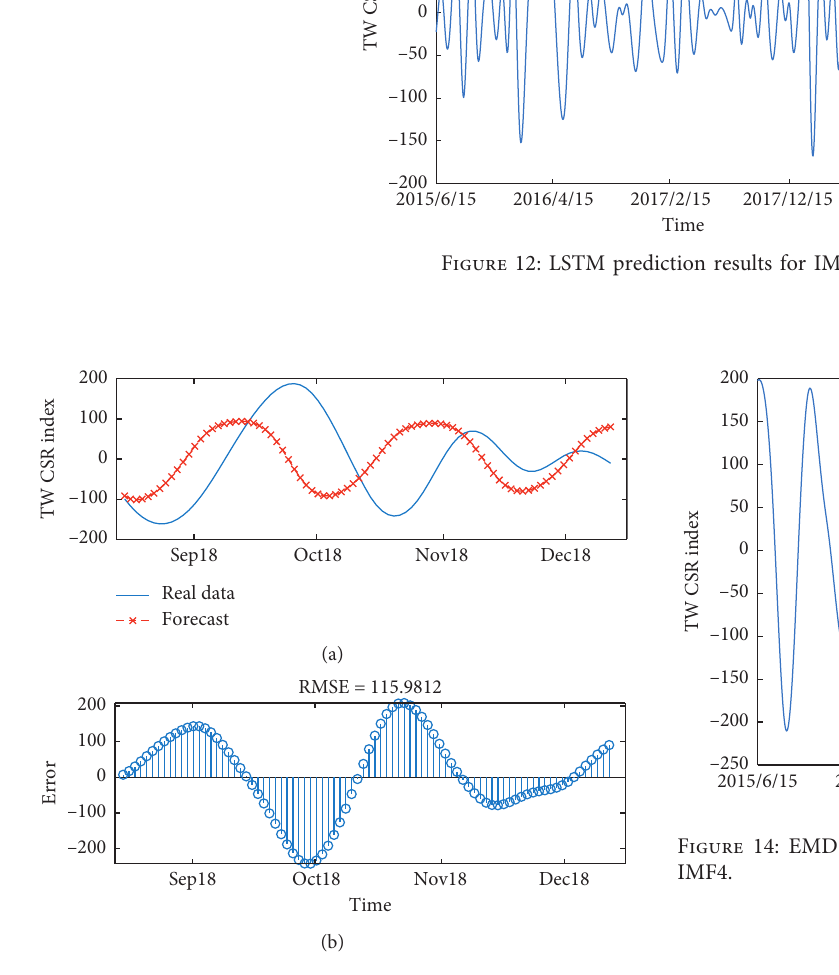
Figure 13: LSTM prediction and actual verification results for IMF3 with RMSE of 115.9812.